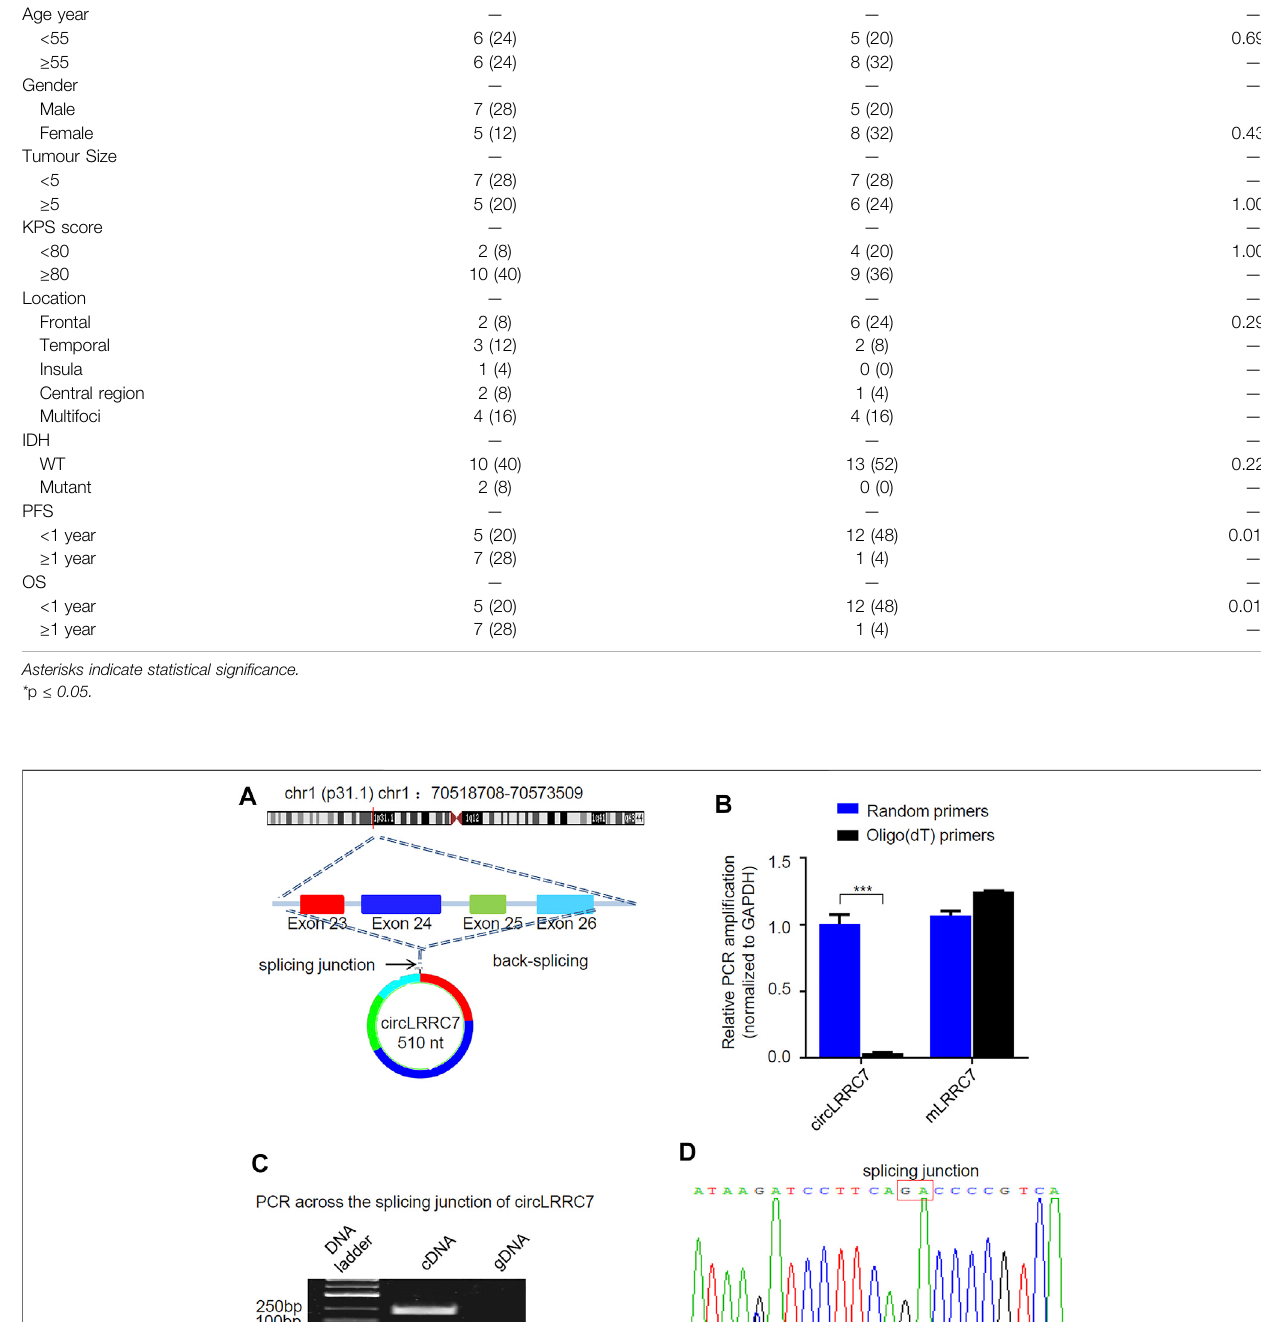
TABLE 3 | Clinical characteristics of GBM patients with different circLRRC7 expression. Variable